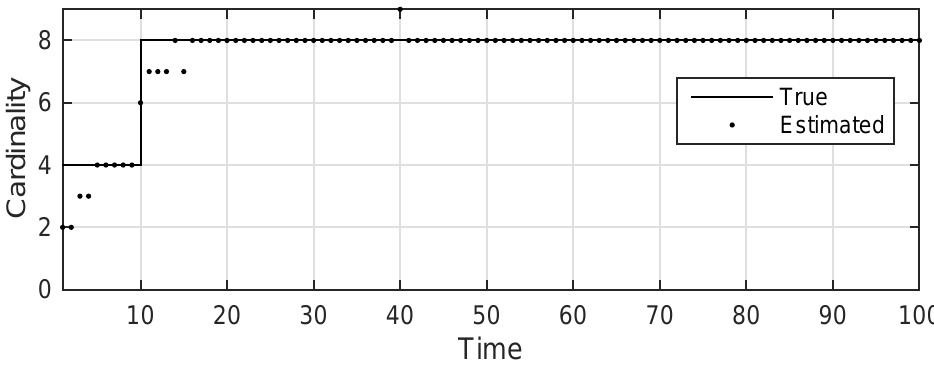
Figure 17. The estimated number of targets by GLMB filter for experiment 2.